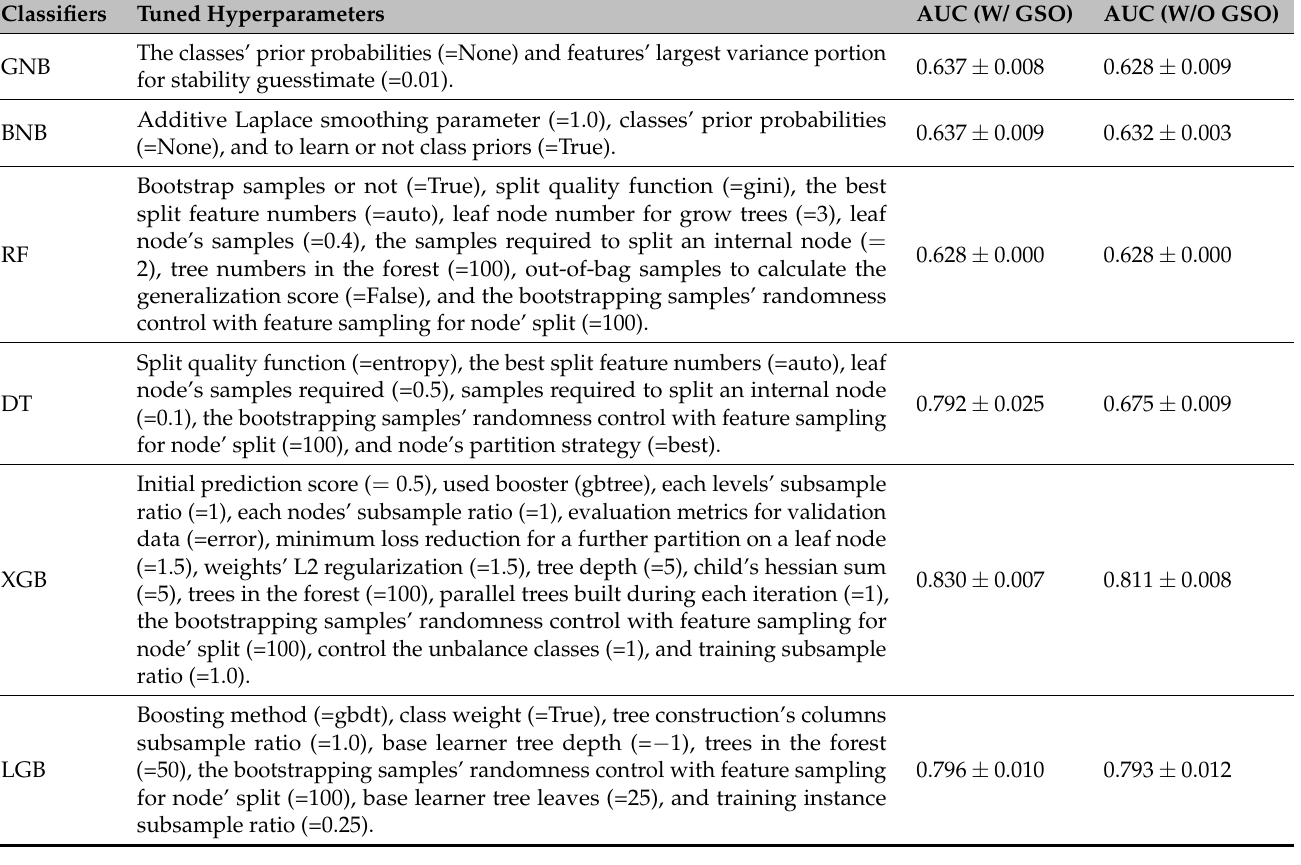
Table 6. The highest achievable AUC for the DDC dataset with hyperparameters tuning of the six ML